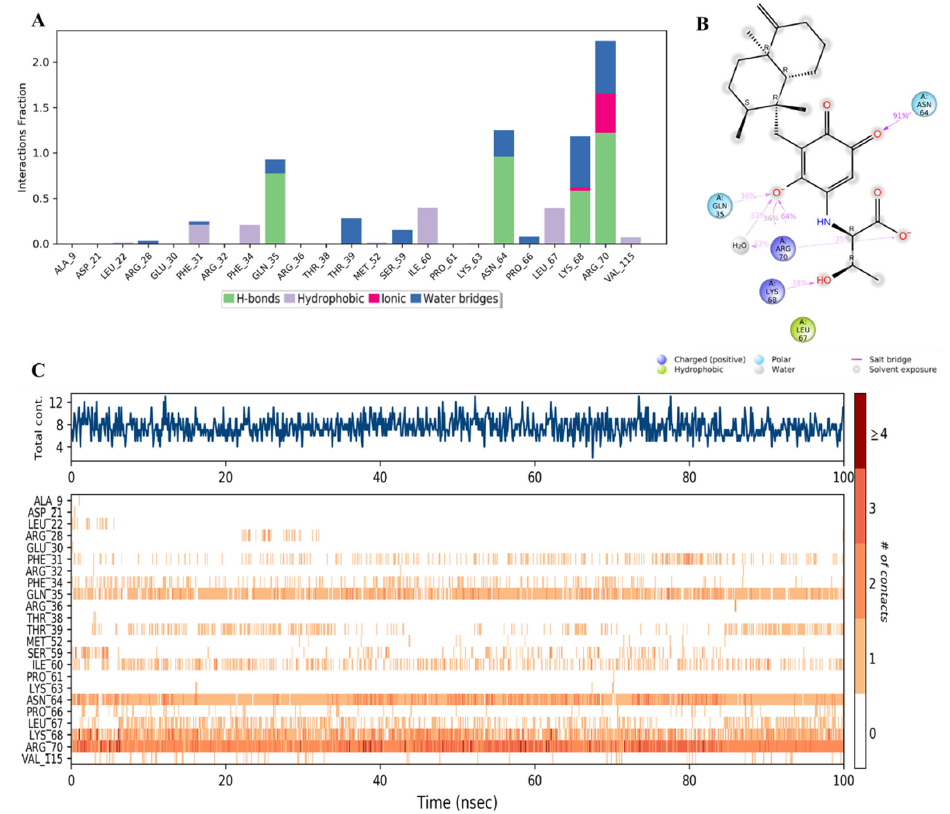
Figure 16. ( A ) Stacked bar graph of hDHFR (PDB: 1KMV) interactions with compound 34 throughout the simulation. The values were normalized over the course of the trajectory. ( B ) A diagram illustrating the detailed connections of 34 with hDHFR. The coordination that appears at least 30% of the designated time period (0.00 to 100.00 nsec) will be presented. It is possible to observe more than 100% as some residues might be linked to the same ligand atom more than once; the pink colored arrows represent the hydrogen bond interaction while the % on the arrows represent the coordination % during the simulation time. ( C ) Timeline of hDRFR- 34 interactions presented in A . The top panel presents the total number of specific interactions the protein made with the ligand over the course of the trajectory. The bottom panel presents the residues interacting with the ligand in each trajectory frame. The dark orange color indicates more than one specific interaction is made between some residues and the ligand. As the orange color becomes lighter, the number of contacts between the residue and ligand decreases. The white color indicates no interaction is formed.